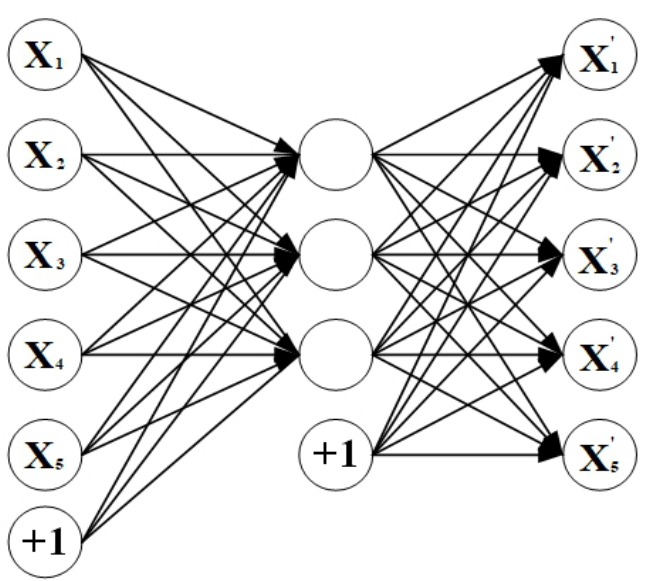
Figure 7. The main body of the simple AutoEncoder (AE).